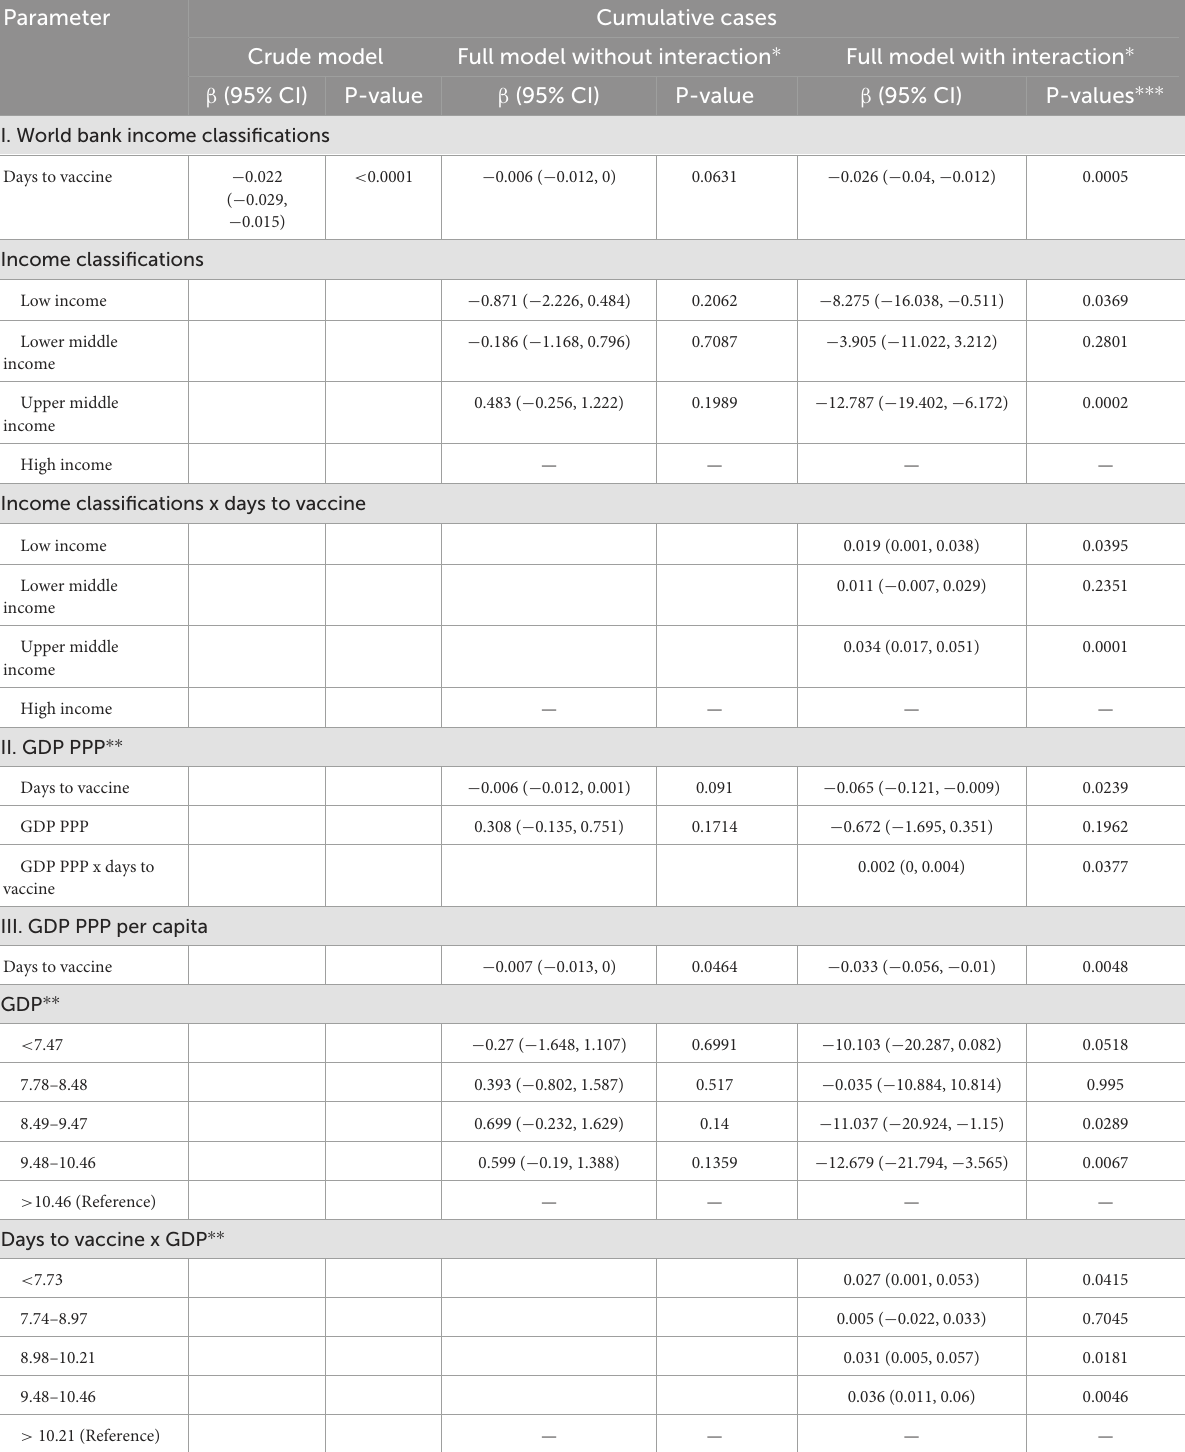
TABLE 1 Assessing the interaction between economic classification on the associations between time to the first vaccine and cumulative cases.